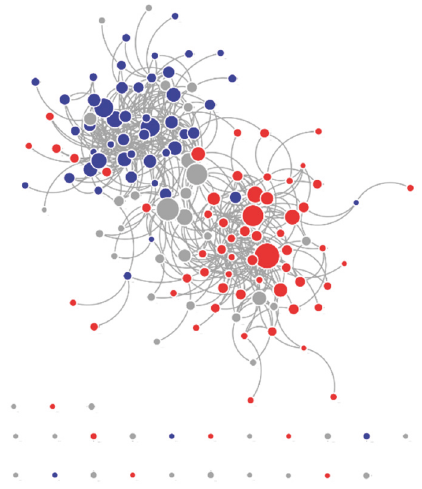
Figure 5: Subgraph of the retweet network for the period 11-17 December, 2017, corresponding to 160 nodes with 𝑘 𝑖𝑛 > 200. Elite nodes associated with Pi˜nera (red) and Guillier (blue) preferences. The rest of the nodes (grey) are not included in the elites. Size of nodes corresponds to 𝑘 𝑖𝑛